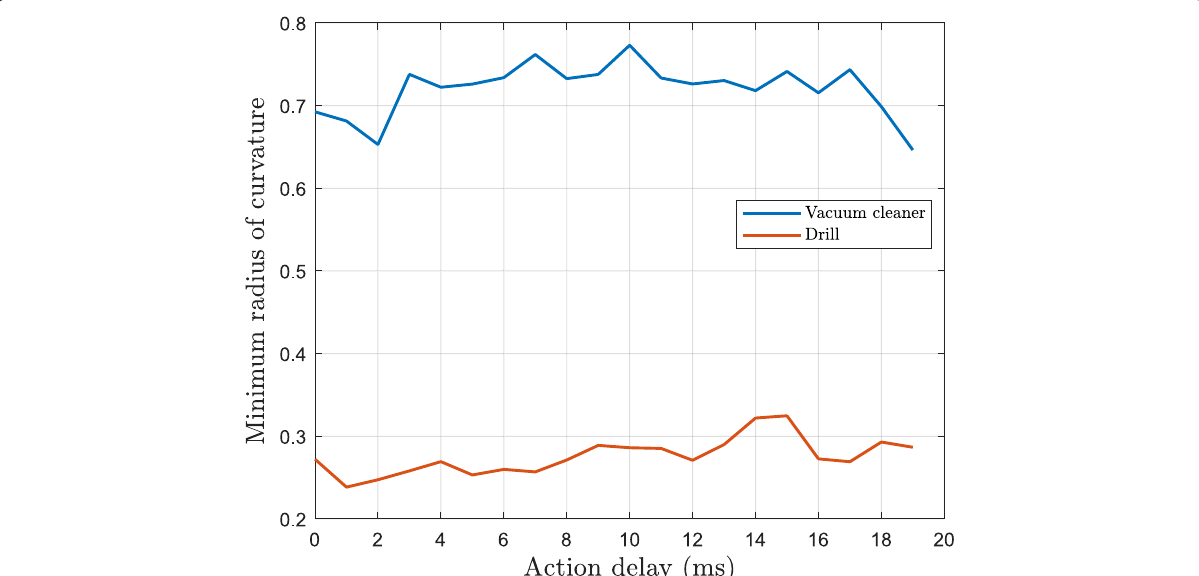
Fig. 17 Stability of the minimum radius of curvature versus various values of the grid phase (action delay) for two appliances (a drill and a vacuum cleaner). Action delay is the delay w.r.t. the (positive-to-negative) zero-crossing of the voltage signal before switching-on an appliance, e.g., an action delay of 4 ms means that the appliance is switched-on after 4 ms of voltage zero-crossing